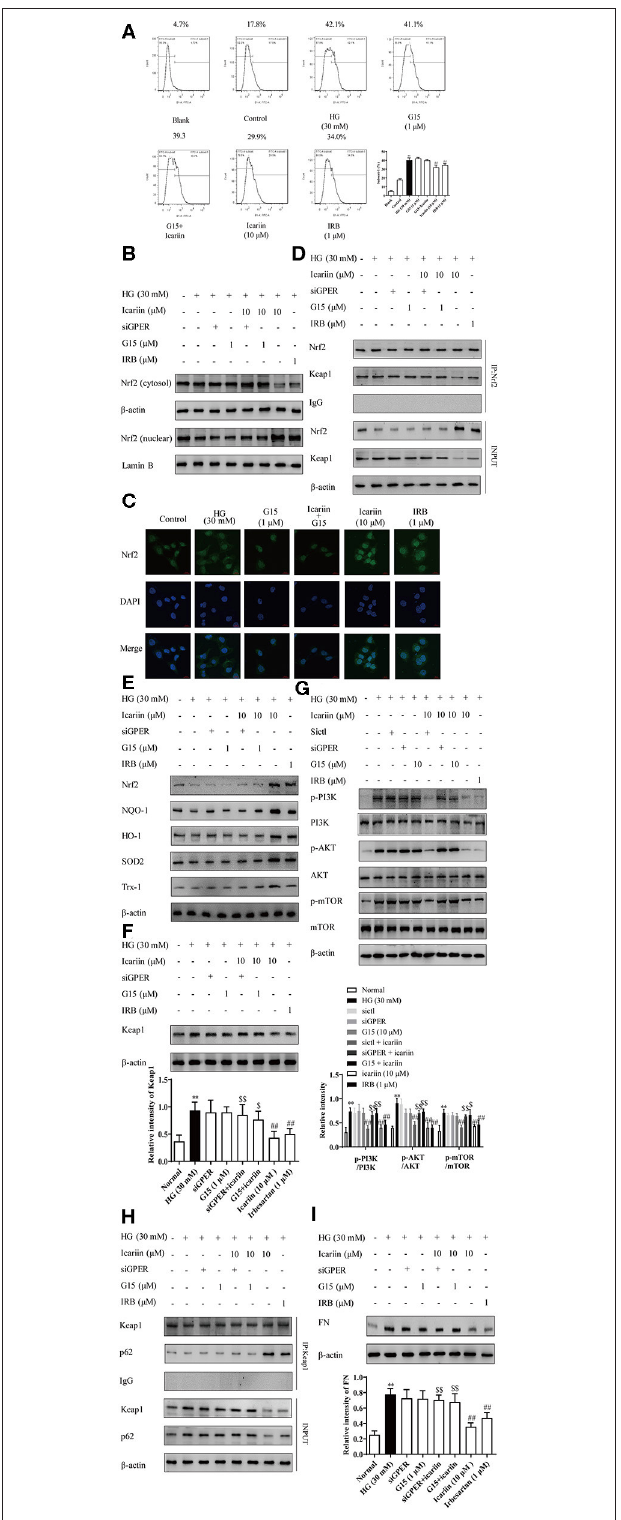
FIGURE 9 | Effect of icariin on GPER mediated p62-dependent Keap1 degradation and Nrf2 activation. The cells were treated with NG (5.6mM), HG (30mM), HG (30mM) + G15 (1 µ M), HG (30mM) + siGPER, HG (30mM) +